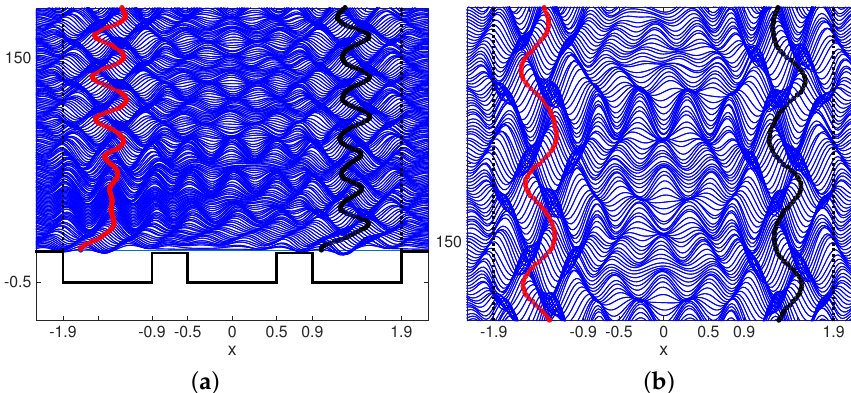
Figure 10. ( a ) On the left, we observe two droplets oscillating within their respective cavities. Through transmission over the barriers, the wave-mediated dynamics allow for a mild interaction between the two droplets. ( b ) On the right graph we observe a detail of the more complex wave-field pattern, in contrast to the simpler wave sloshing seen in Figure 9. The current wave pattern indicates some crossing of information in both directions.